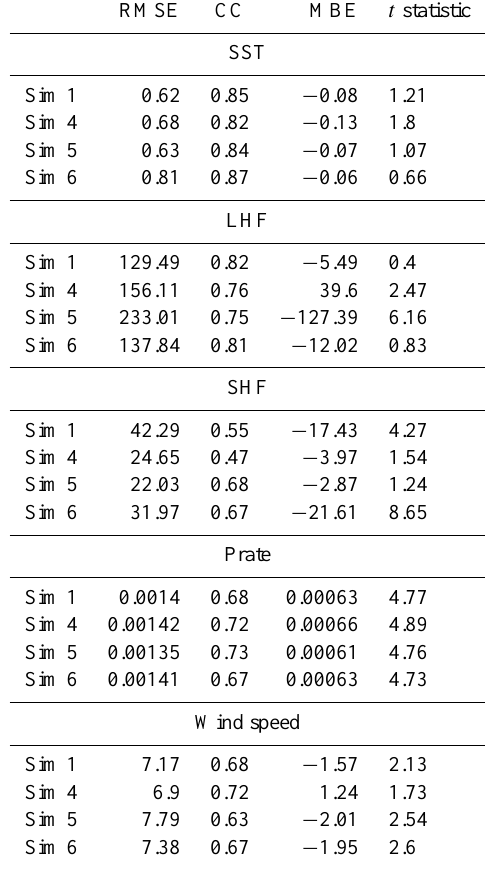
Table 7. The values of statistic parameters for confirming the best combinations suggested for the selected parameters.